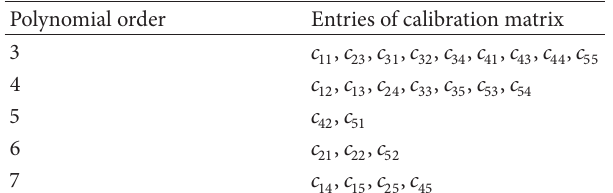
Table 1: Polynomial orders for all entries of the compensation